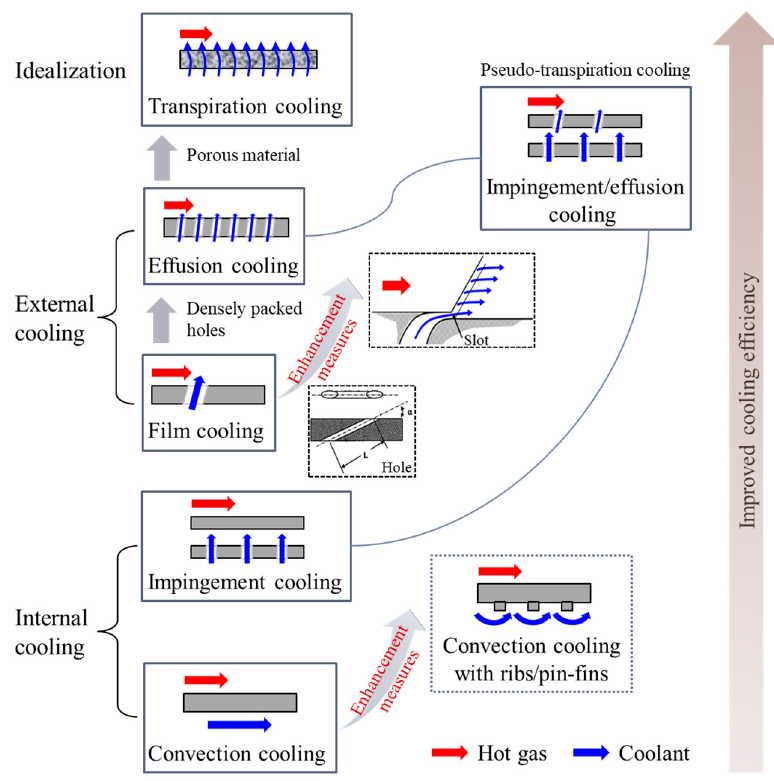
Figure 4. Overview of advances in turbine blade cooling schemes.